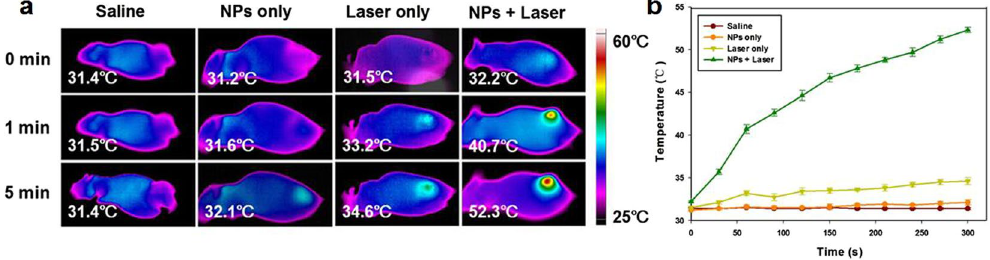
Figure 5. In vivo PTT effectiveness of Fe 3 O 4 /ICG@PLGA/PFP NPs. ( a ) IR thermal images showing the temperature changes in tumors in mice that received different treatments. ( b ) Peak temperature profiles in tumors with different